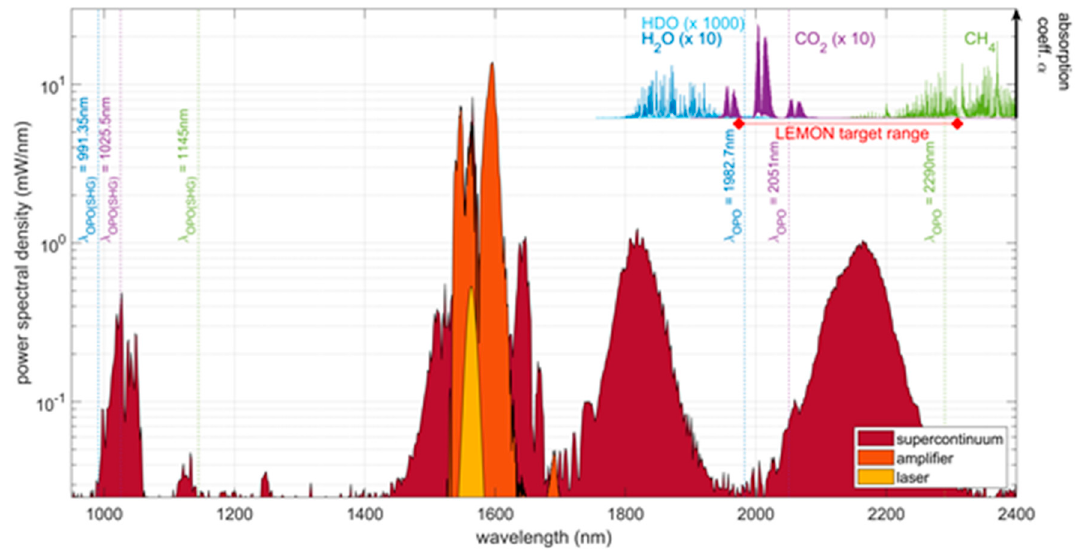
Figure 19. Laser spectrum together with spectrum after fiber amplifier and supercontinuum generated in a nonlinear fiber. In addition, the relevant absorption bands for the molecules are shown together with the interrogation wavelengths generated by the emitter.